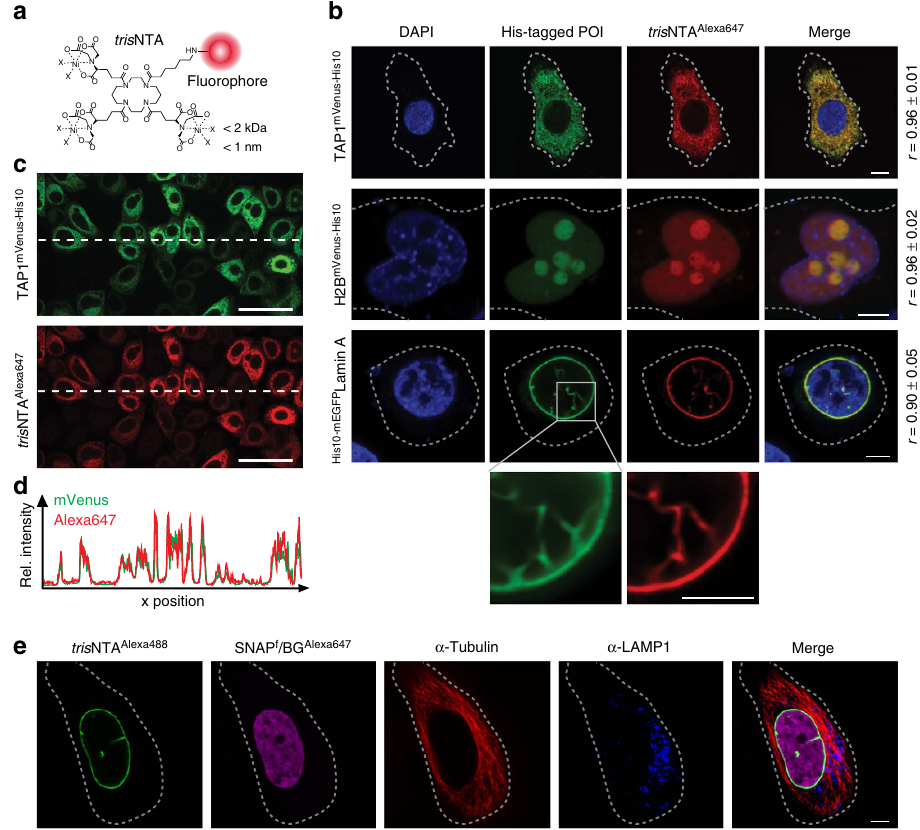
Figure 1 | ‘Traceless’ tracing of protein assemblies by a minimal lock-and-key recognition pair. ( a ) Chemical structure of tris NTA conjugated to various organic fluorophores (red circle). ( b ) Subcellular tracing of His-tagged POIs by tris NTA Alexa647 . Cells expressing TAP1 mVenus-His10 (HeLa Kyoto), H2B mVenus-His10 (HeLa) or His10-mEGFP Lamin A (Chinese hamster ovary (CHO-K1)) were fixed and stained with tris NTA Alexa647 . Excellent co-localization (merge) between tris NTA Alexa647 (red) and all His-tagged POIs (green) was observed. Pearson’s coefficients ( r ) were calculated from eight to ten individual images (right). Dashed lines indicate the cell border. ( c ) Specific labelling of TAP1 mVenus-His10 by tris NTA Alexa647 in fixed HeLa Kyoto cells with a Pearson’s coefficient of r ¼ 0.95. ( d ) Cross-section of relative fluorescence intensities (mVenus and Alexa647), indicated by a horizontal dashed line in c shows excellent correlation of His-tagged POI expression level and tris NTA Alexa647 staining. ( e ) Combination of the lock-and-key element with established labelling methods. HeLa Kyoto cells expressing His10 LaminA and H2B SNAPf were simultaneously labelled with tris NTA Alexa488 , benzyl guanine (BG) Alexa647 and antibodies against tubulin, as well as the lysosomal protein lysosomal-associated membrane protein 1 (LAMP1). Scale bars, 5 m m ( b , e ), 50 m m ( c